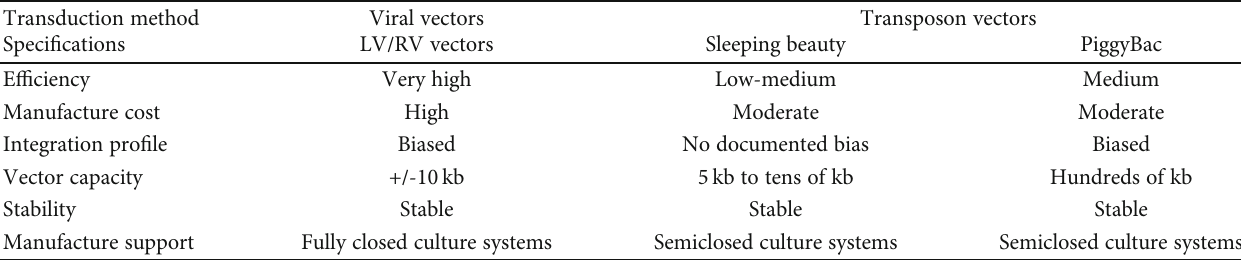
Table 1: Key di ff erences between the available individual types of vectors used for the preparation of CAR